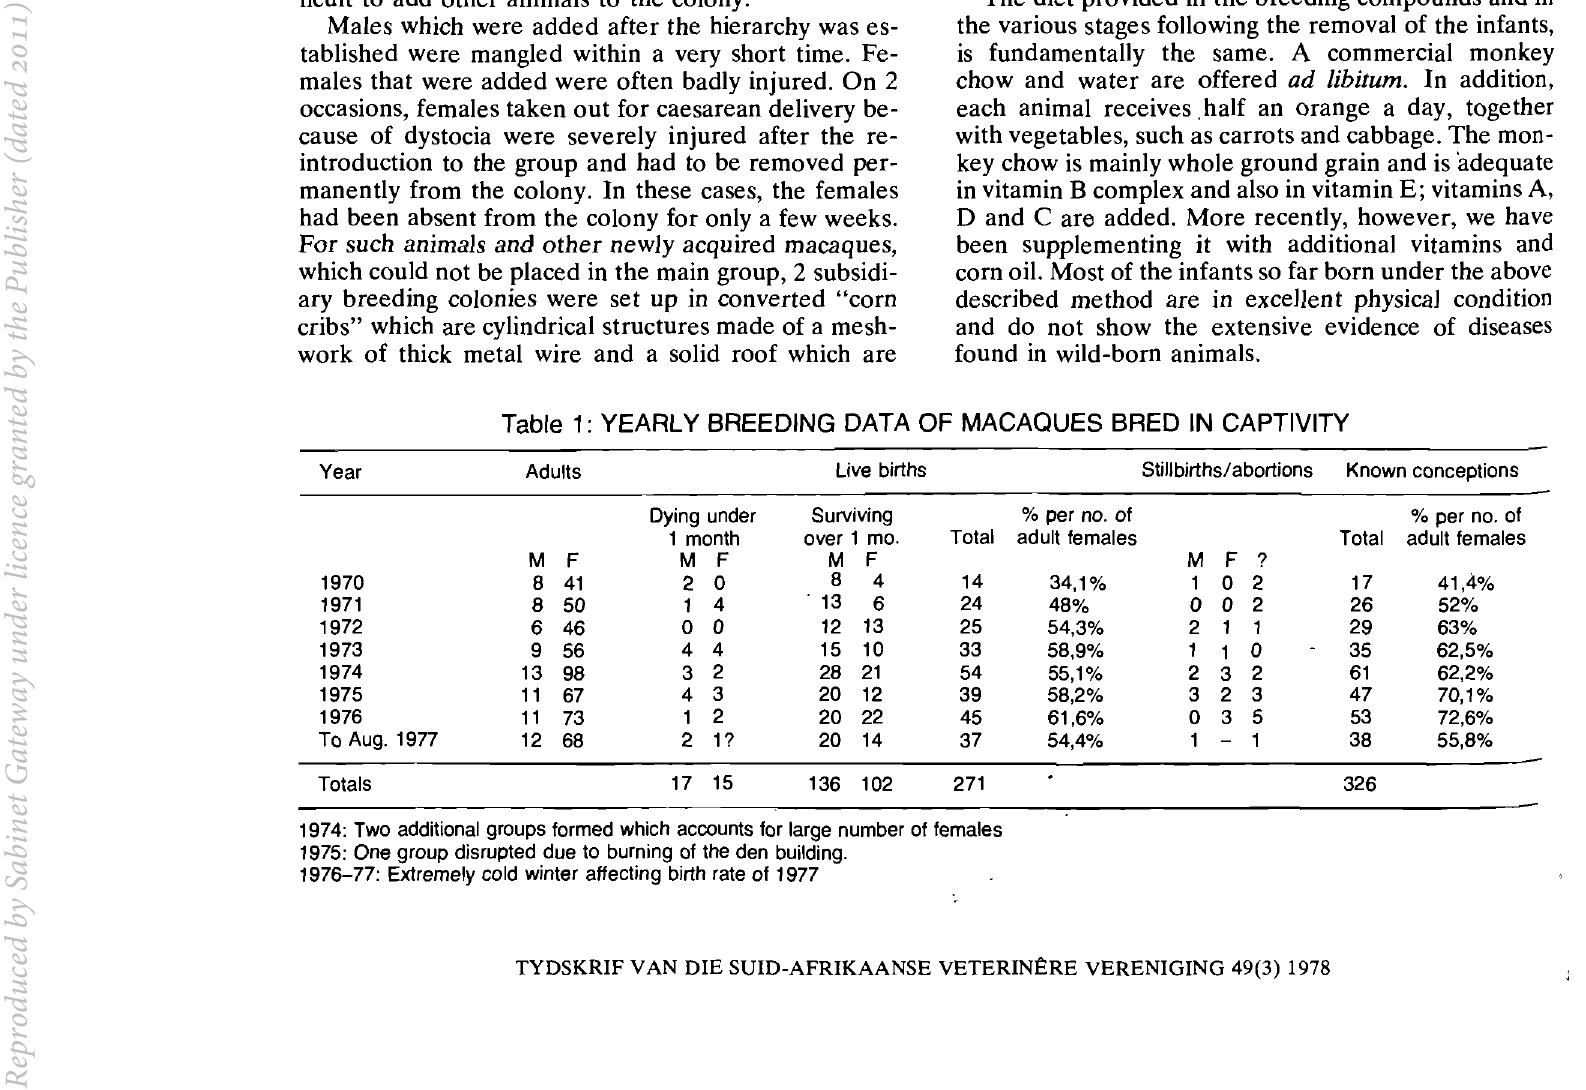
Table 1: YEARLY BREEDING DATA OF MACAQUES BRED IN